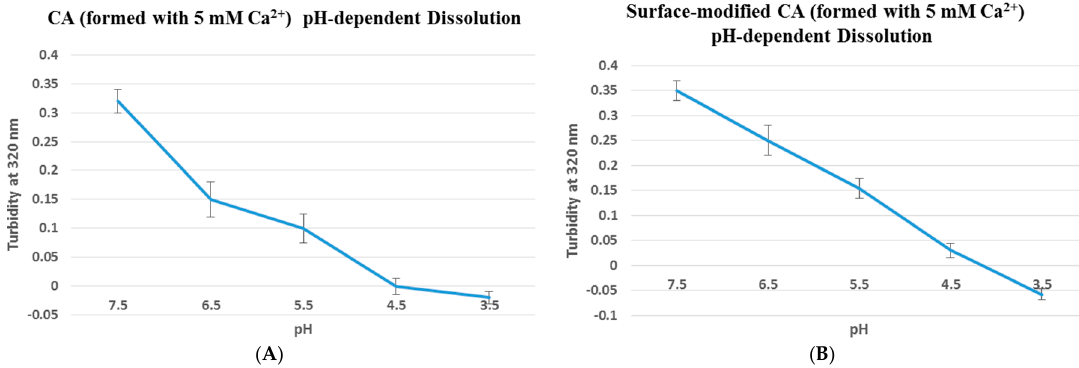
Figure 1. pH dissolution test was done using UV spectrophotometer at 320 nm wavelength. Particles without ( A ) or with ( B ) surface-coating (streptavidin–biotin PEG–fibronectin) were initially fabricated in 100 μ L of bicarbonate-buffered DMEM media (pH 7.5), followed by addition of DMEM media of decreasing pHs (6.5, 5.5, 4.5 and 3.5) to top up to 1 mL, prior to the turbidity measurement. Turbidity value of 0.36 indicates that particles were already formed at pH 7.5, and with decreasing pHs the particles started to dissolve, resulting in lower turbidity value until reaching close to 0 where all particles were completely dissolved.